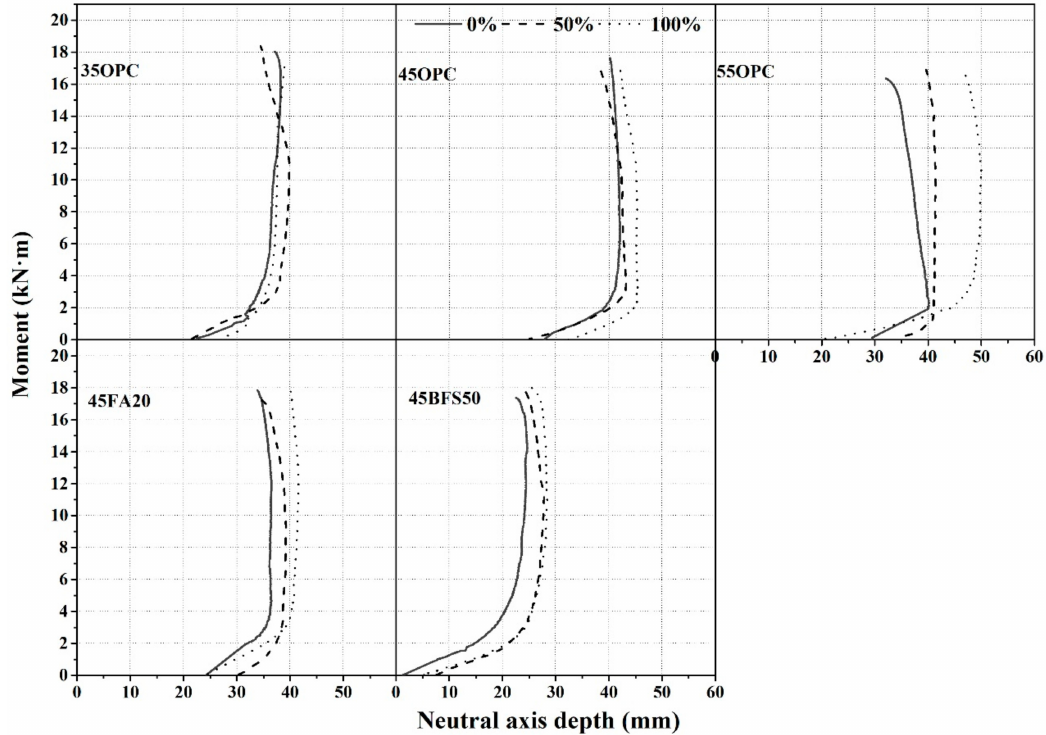
Figure 7. Location of the neutral axis